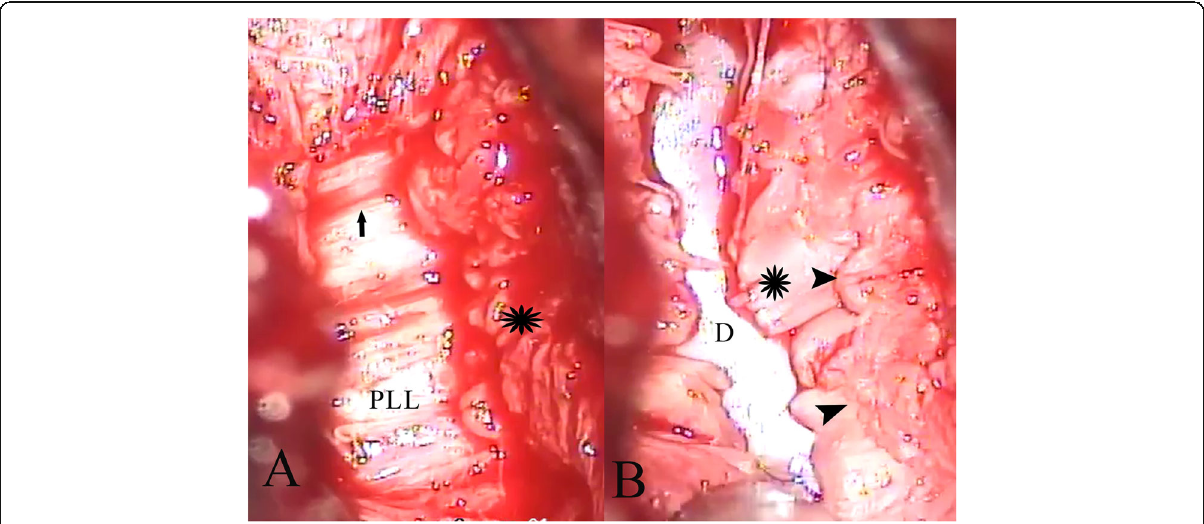
Fig. 2 a Operative view showing an intact PLL. Arrow points to the site of microhook entry to dissect. The asterisk refers to the posterior annulus. b After opening the PLL. D dura, the asterisk refers to the edges of PLL, and the arrowhead points to the